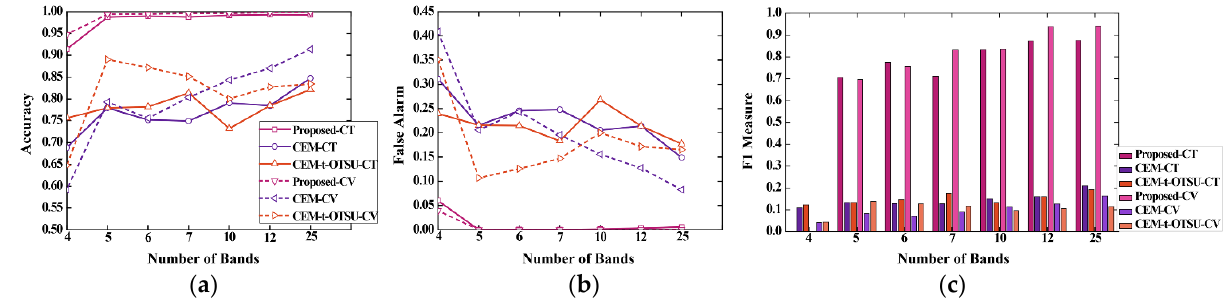
Figure 22. The quantitative comparison of the detection results of two targets in the UAV scene. ( a ) The curves of A C using different methods for the two targets. ( b ) The curves of F a using different methods for the two targets. ( c ) The histograms of F 1 using different methods for the two targets.